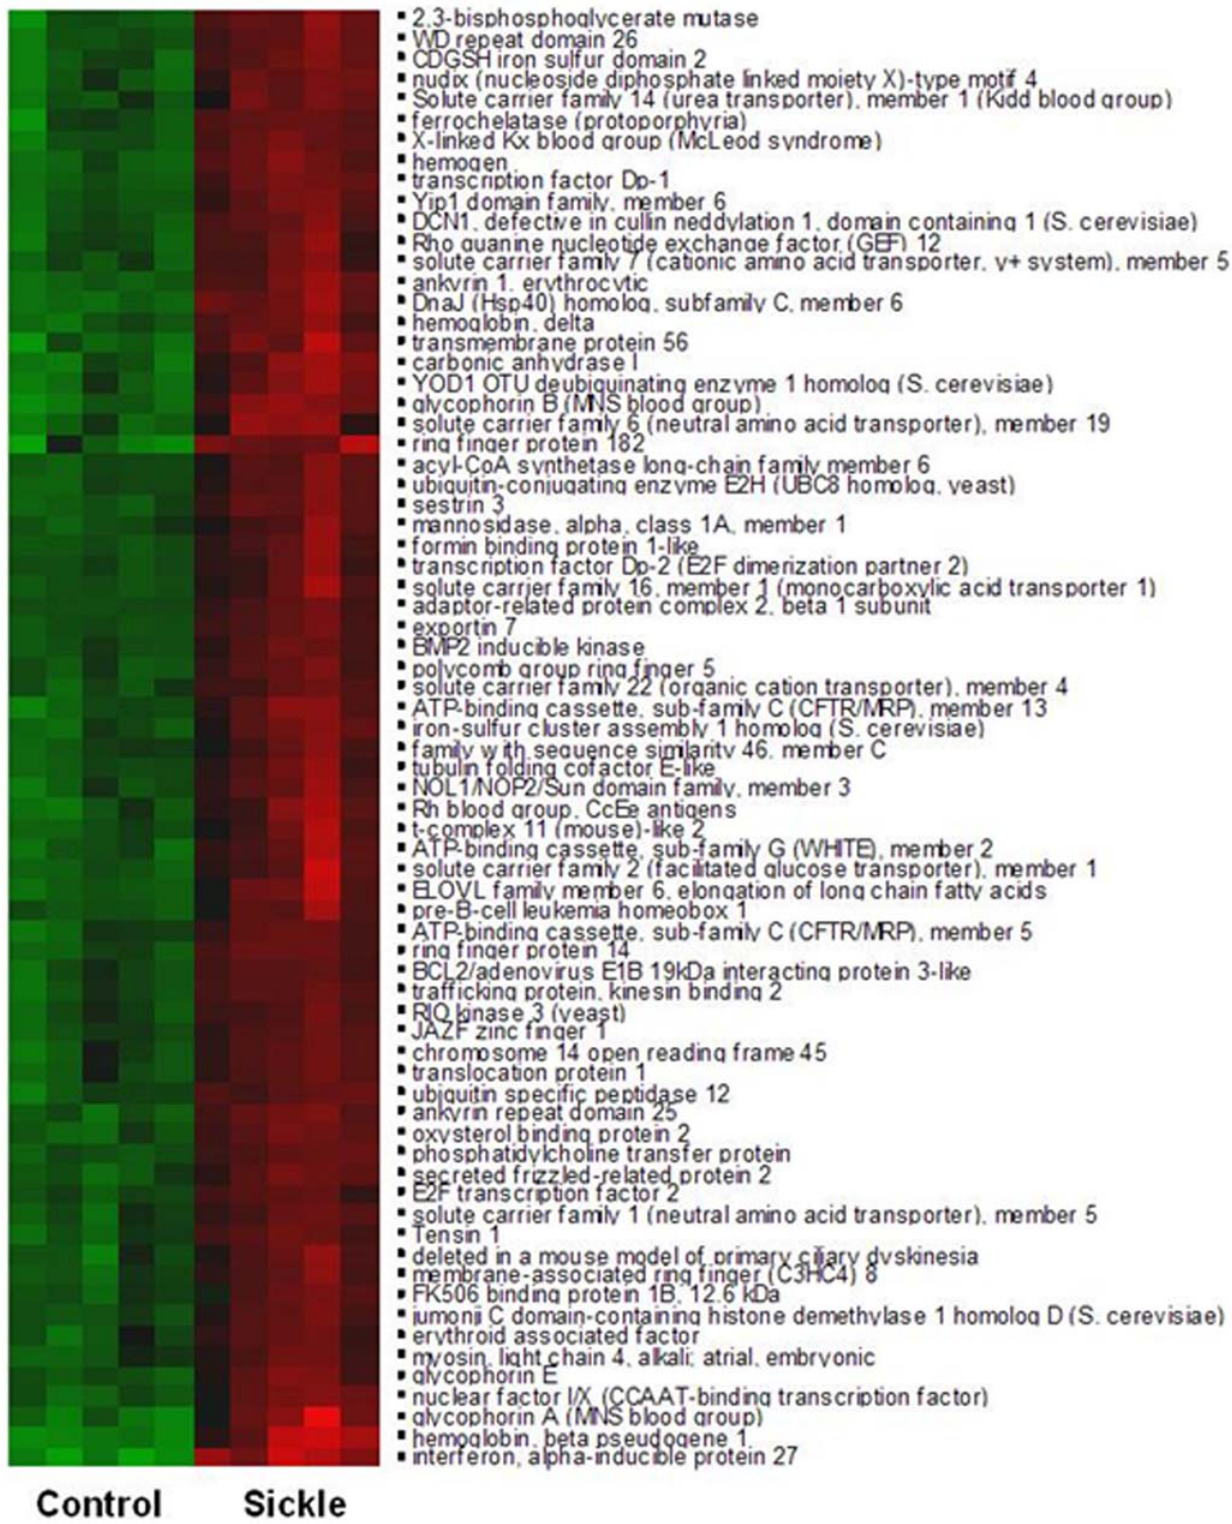
Figure 7. Heat Map of differential gene expression in PAX-GR in sickle cell disease (n=5) in comparison to control subjects (n=5). Cluster analysis was applied to gene expression data derived from all probes on HG-U133 plus 2.0 at FDR 10% and FC . 5.0. The level of expression of each gene in each sample relative to the median level of expression of that gene across all samples is represented using a red, black and green color scale (green – below median; black – equal to median; red - above median). The dendrogram displays the unsupervised clustering of patients and control subjects using the differentially expressed gene list.